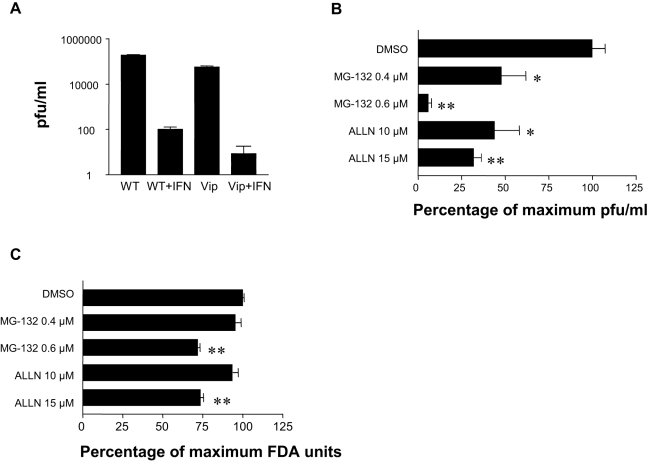
The effect of viperin overexpression and proteasome inhibitors on viral growth.(A) Wildtype (WT) and viperin overexpressing (Vip) A549 cells, with or without 12 hrs pre-treatment with IFNβ (500 U/ml), were infected with dengue virus TSV01 (MOI 1) for 48 hrs. Plaque forming units/ml in cell culture supernatant, as determined by plaque assay, are shown as mean (n = 3)±s.e.m. Significance (P<0.05) was determined by students t-test, comparing wild type A549 (WT) to viperin overexpressing cell (Vip) a P value of 0.00004 was obtained. (B) HepG2 cells were incubated with MG-132 (0.04 µM and 0.4 µM in DMSO) and ALLN (1 µM and 10 µM in DMSO) and DMSO alone for 2 hrs prior to infection with dengue virus TSV01 (MOI 10) for 48 hrs. Plaque forming units/ml in cell culture supernatant, as determined by plaque assay, are shown as mean (n = 3)±s.e.m. Significance (P<0.05) was determined by students t-test, comparing each treatment to DMSO alone. The cytotoxicity was measured in parallel using FDA (C).